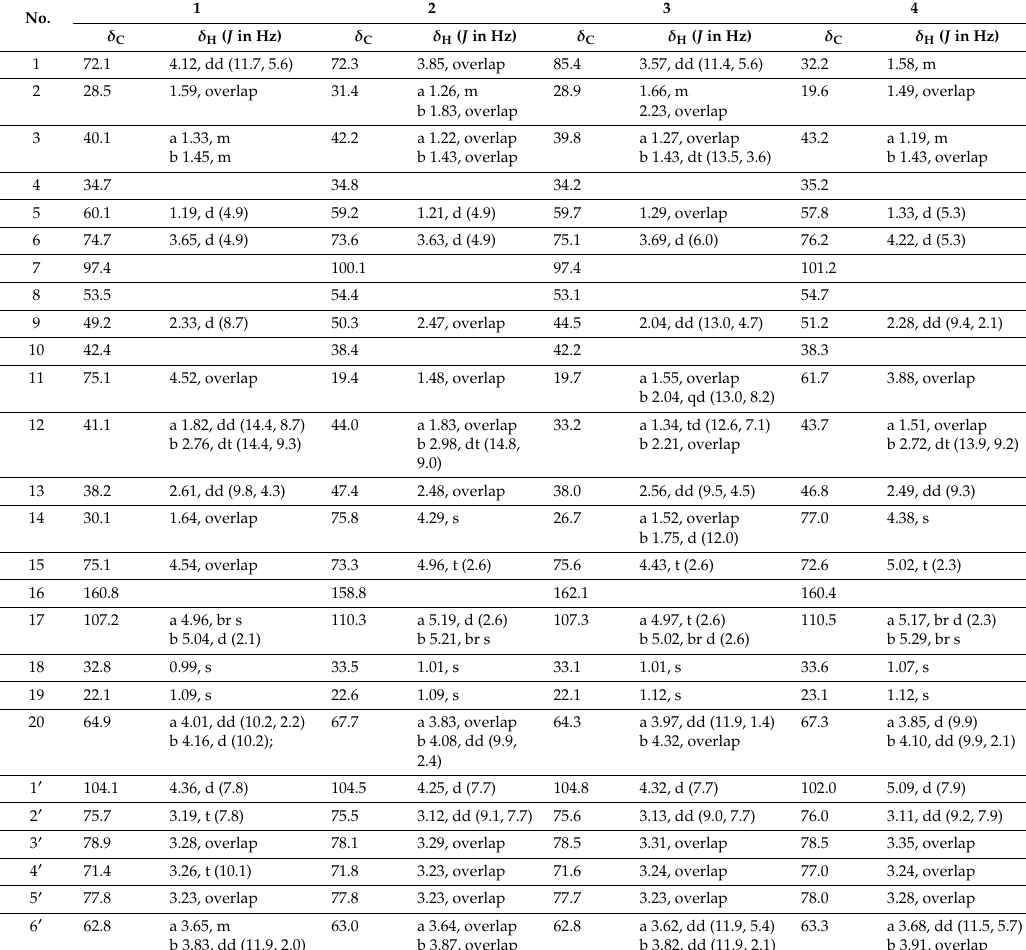
Table 1. 1 H and 13 C NMR data of Compounds 1 – 4 in CD 3 OD (500 and 125 MHz δ in